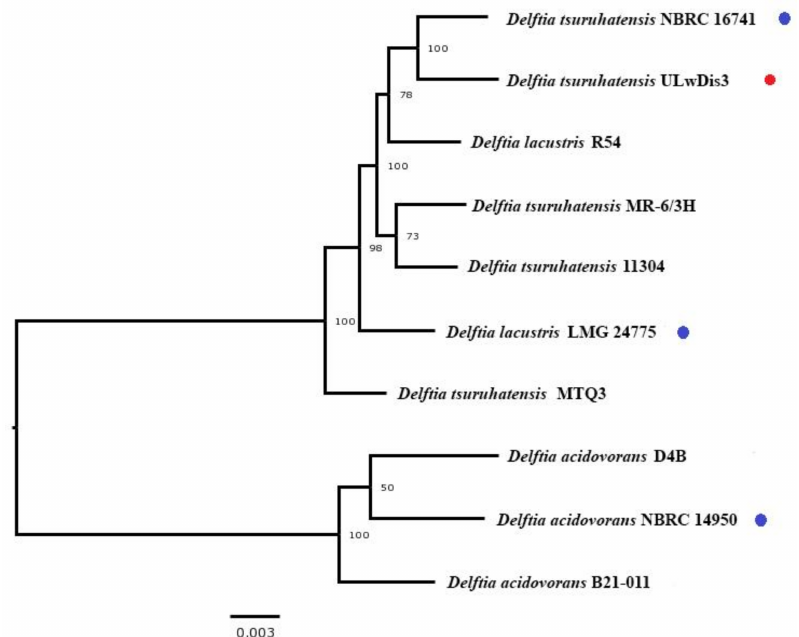
Figure 1. Whole-genome tree of the type Delftia strains (blue markers), Delftia tsuruh atensis ULwDis3 (red marker) and other members of the species Delftia carried out using the PATRIC